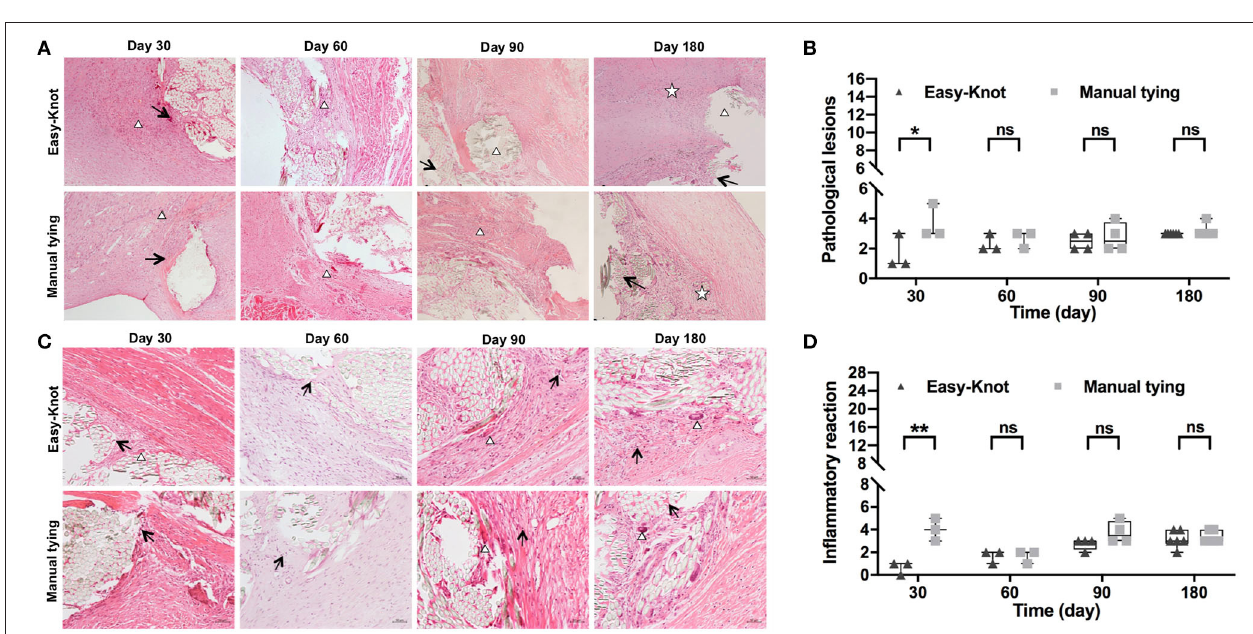
FIGURE 7 | Representative gross and histological view of thrombi at knotting site at Day 180 and thrombosis grade at indicated time points. (A) Morphology of the left atrial surface at the implantation site of the annuloplasty ring. Two of the six titanium clips were completely coated with proliferative fibrous tissue ( ↑ ), red thrombosis was observed at 3 thread ends ( 1 ). (B) Hematoxylin-eosin (H&E) staining of the thread end of a titanium clip ( 1 ). (C) Thrombosis grade of the Easy-knot group and the manual-tying group at indicated time points. * p < 0.05; ** p < 0.01; ns, not significant.